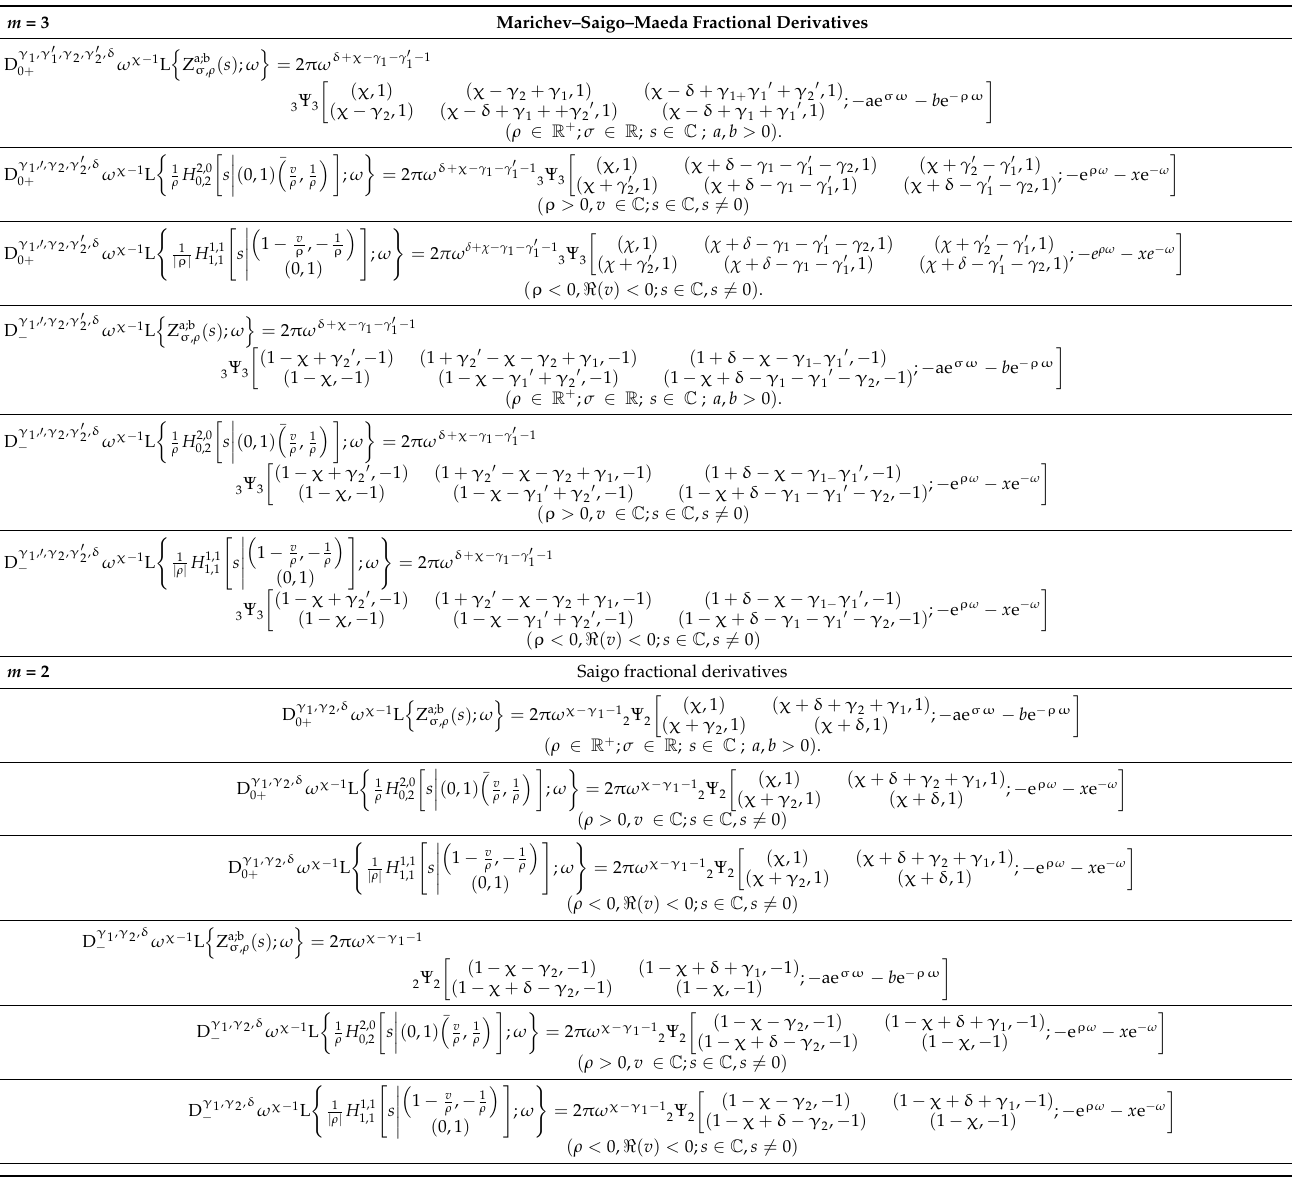
Table 3. Fractional derivatives formulae involving the generalised Krätzel function Z a;b σ , ρ ( s ) and H